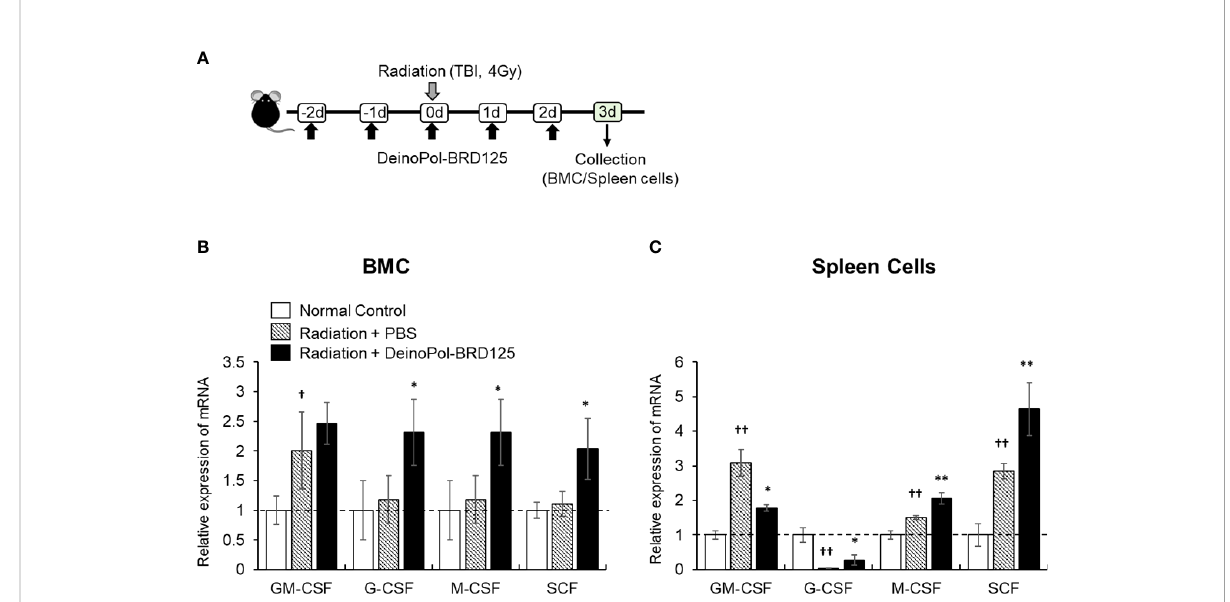
FIGURE 7 Modulation of hematopoiesis-related cytokine expression by DeinoPol-BRD125 in irradiated mice. (A – C) Mice (n=3) were injected intraperitoneally twice before irradiation and an additional third time after irradiation with DeinoPol-BRD125 (50 mg/kgBW). Bone marrow cells (BMC) and spleen cells were collected at 3 days after irradiation. Schematic schedule of hematopoietic stem cell cytokine expression experiment (A) . mRNA expressions of hematopoietic-related cytokine (GM-CSF, G-CSF, M-CSF, SCF) in BMC (B) and spleen (C) were quanti fi ed using real time PCR. † p<0.05 and †† p<0.01, compared to normal control; *p<0.05 and **p<0.01 compared to PBS-injected irradiated